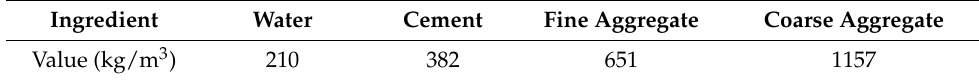
Table 2. The mix composition of the concrete.